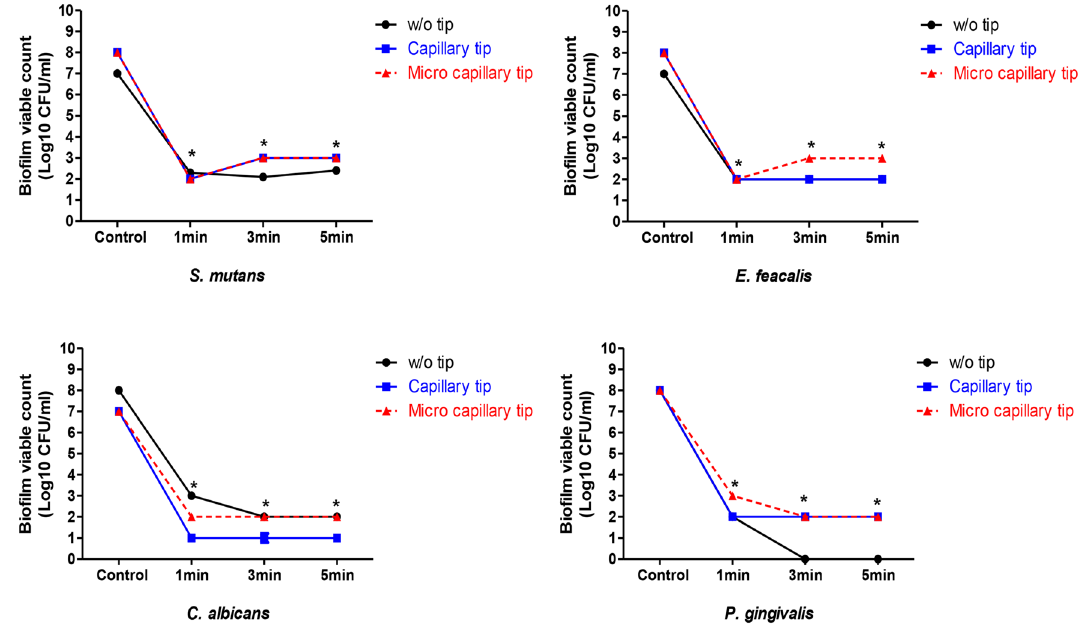
Figure 5. The effect of dental tip mounting on the bactericidal activity of NCP in liquid medium. Four kinds of oral microbes ( S.mutans, E.faecalis, C.albicans and P.gingivalis ) inoculated in the liquid medium were subjected to NCP treatment in the condition of unmounted or mounted with capillary or microcapillary tips. The treatment was performed for 1, 3 and 5 min, and the samples were incubated for 24 h further in the liquid medium. The samples were diluted serially, and plated on the solid medium. After 24 h, the colony forming units (CFU) were counted, and presented as a graph. Data shown are the average of three independent experiments, *p <